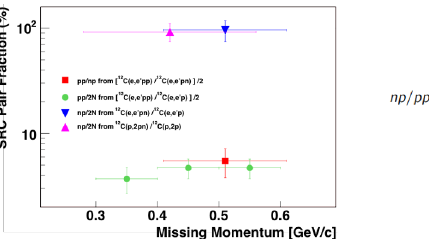
Figure 3. a): The ratio of 12 C ( e , e (cid:48) pN ) events to 12 C ( e , e (cid:48) p ) events as a function of the reconstructed initial momentum of the knockout proton from the 12 C ( e , e (cid:48) p ) reaction. The triangles mark knock out of a proton and a neutron by the proton ( (cid:52) , BNL result) and electron ( (cid:53) ) probes. The circles mark the knockout of two protons. The square shows the 12 C ( e , e (cid:48) pp ) / 12 C ( e , e (cid:48) p ) ratio. Picture is adapted from [4] b) Recent CLAS-6 data analysis established the np-dominance for large range of